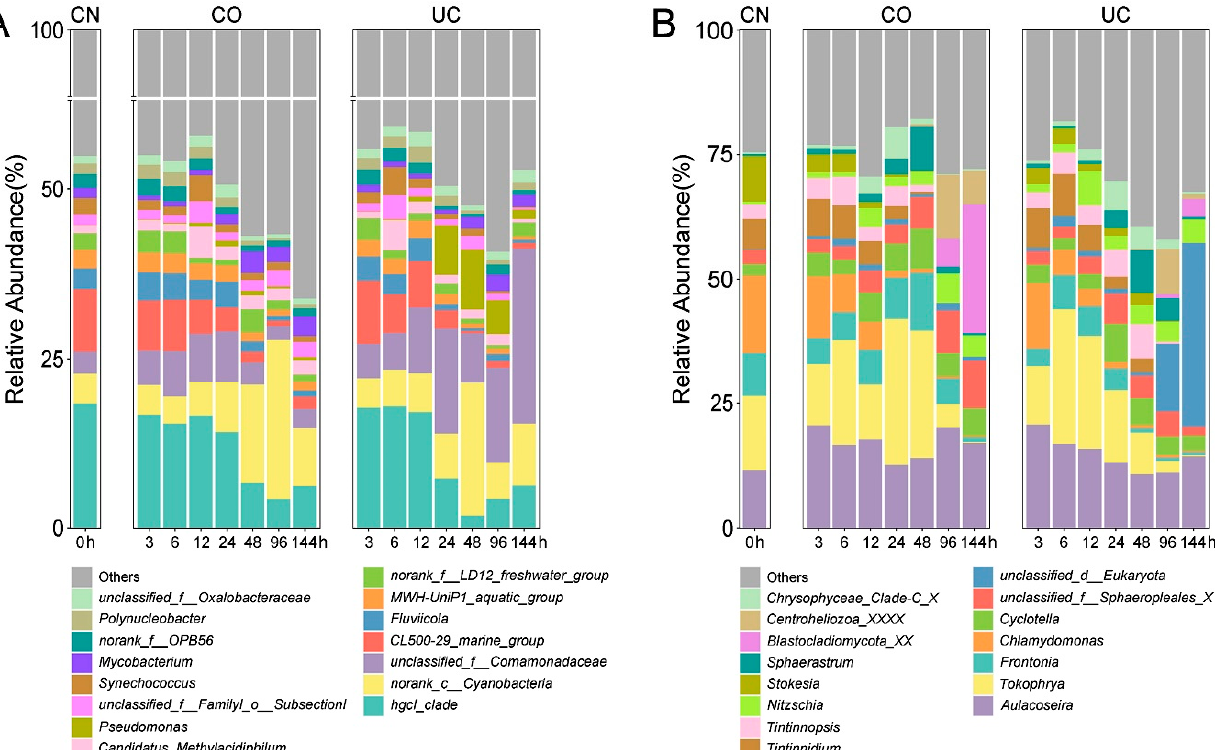
Figure 1. Stacked bar charts of the relative abundance of the prokaryotes ( A ) and eukaryotes ( B ) at the genus level. Shown are the averages from n = 3. CN: control group, CO: with lid closed, UC: without lid.